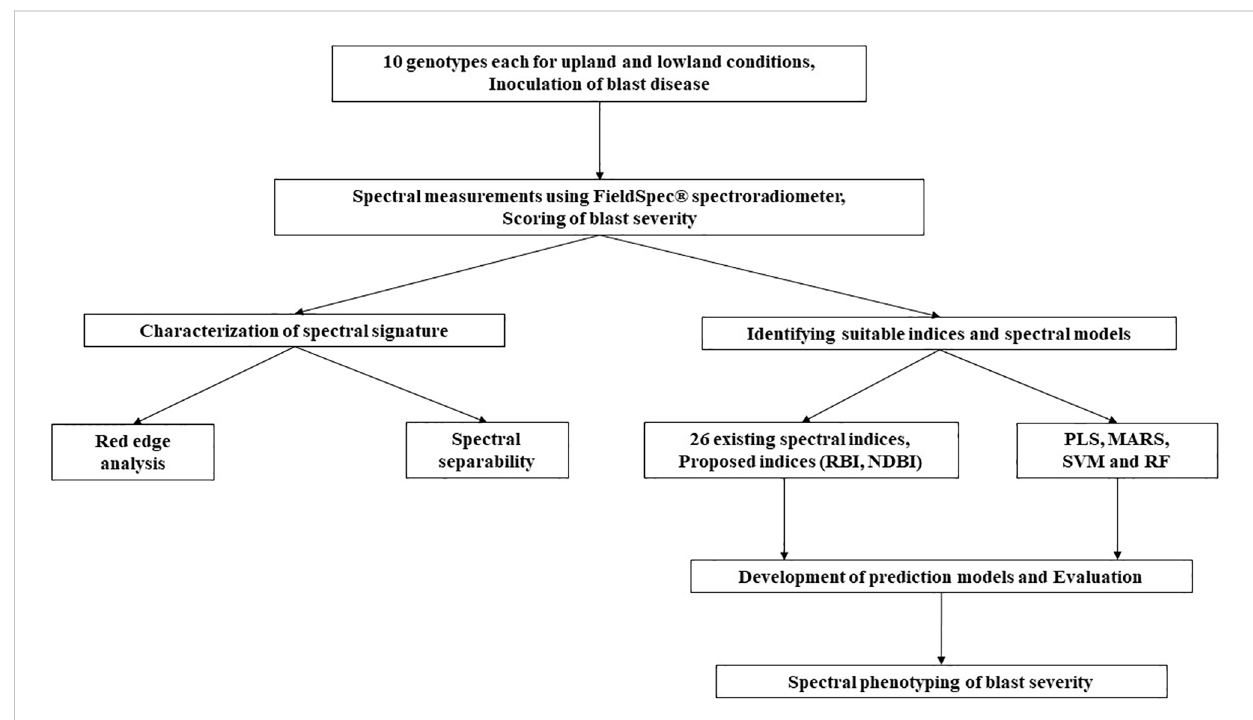
FIGURE 2 The overall work fl ow of the present study.